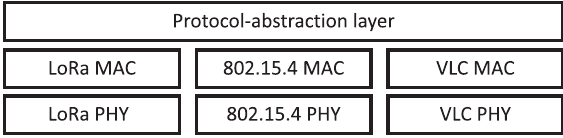
Figure 3. Diagram of the developed architecture.